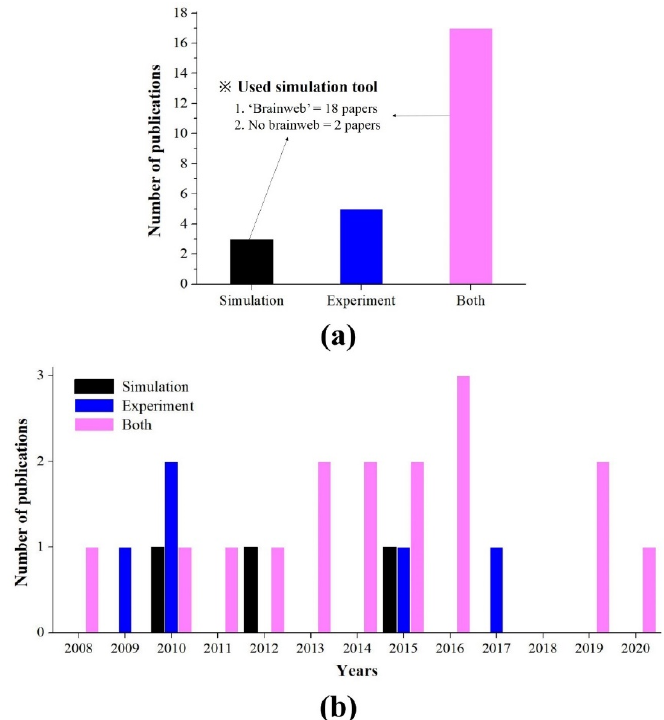
Figure 6. ( a ) Graph of the number of publications of MR imaging using the NLM noise reduction algorithm. The final classification included 25 papers; of those, three major categories of techniques were investigated (real, simulated, and both). Within the “both” category, studies were further classified depending on their use of BrainWeb. ( b ) The total number of papers as function of the publication year. Table 4. Characteristics for types of study from studies retrieved for systematic review. Study